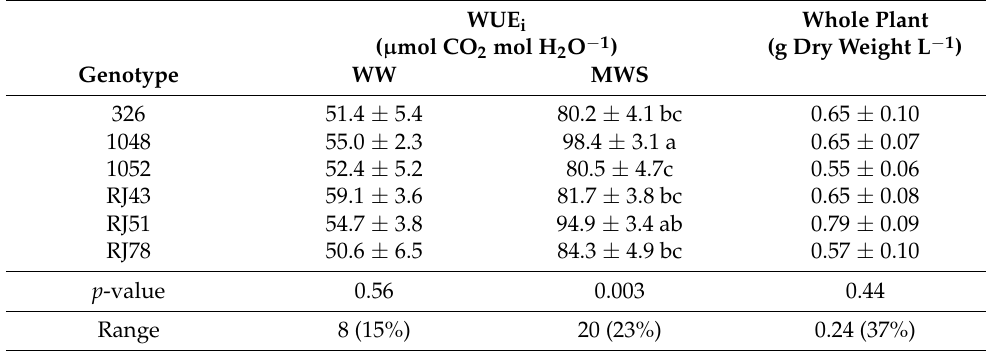
Table 5. Leaf (WUE i ) and whole plant water use efficiency of each genotype. Lower case letters indicate differences between means (Tukeys tests, p